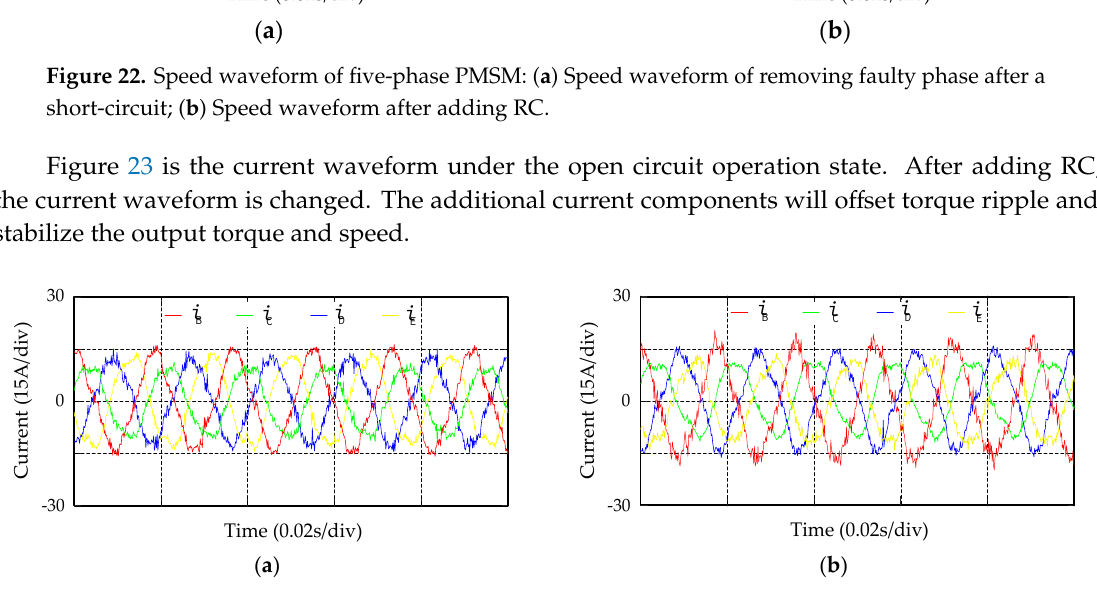
Figure 23. Current waveform of five-phase PMSM: ( a ) Current waveform of removing faulty phase after a short-circuit; ( b ) Current waveform after adding RC.